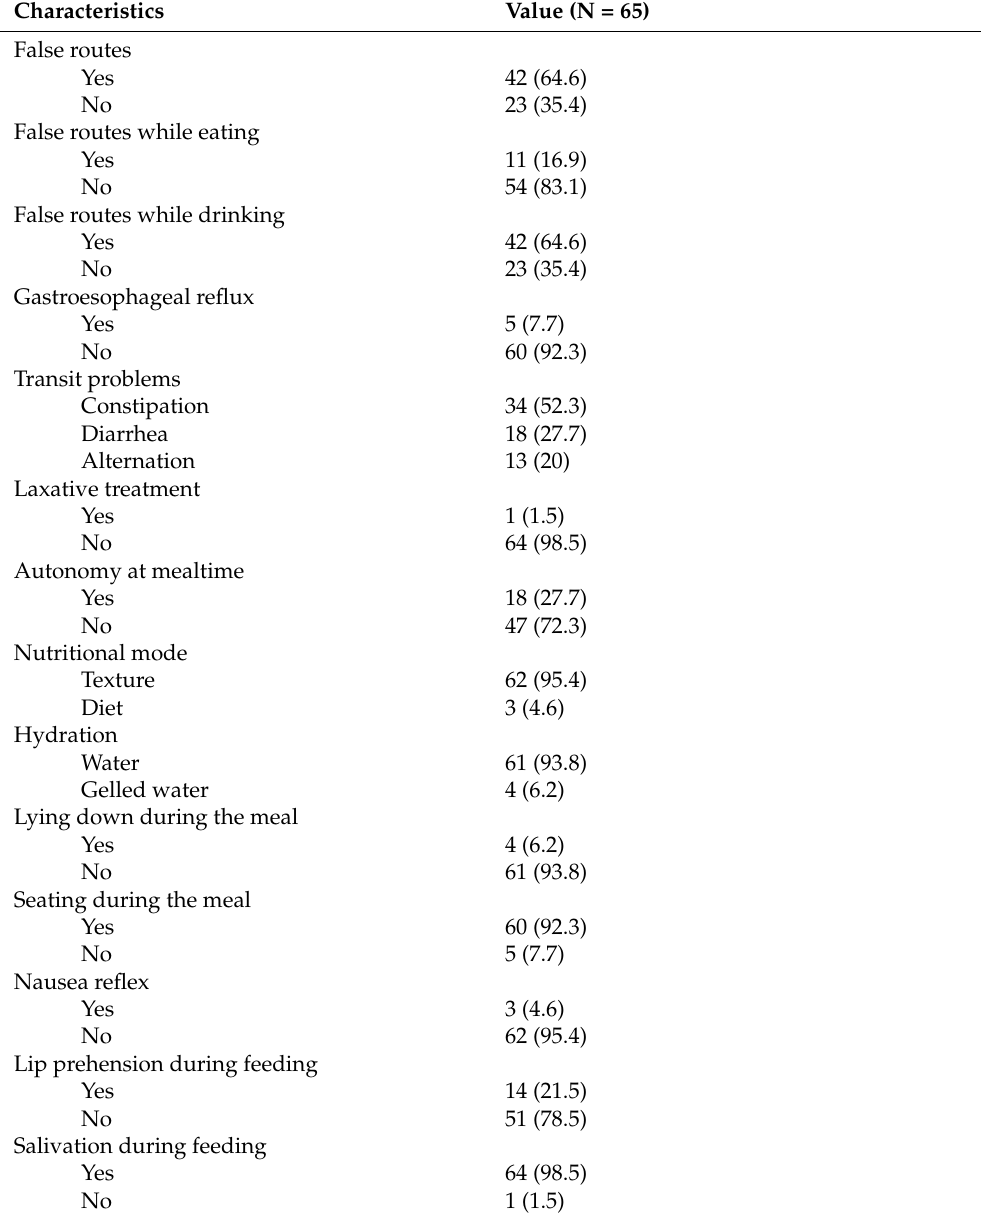
Table 2. Characteristics of swallowing disorders in cerebral palsied patients.